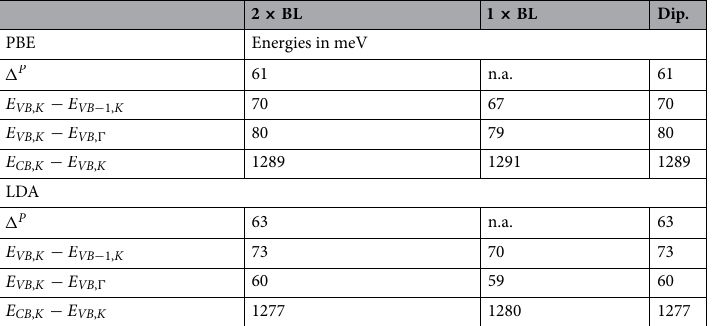
P is the difference between